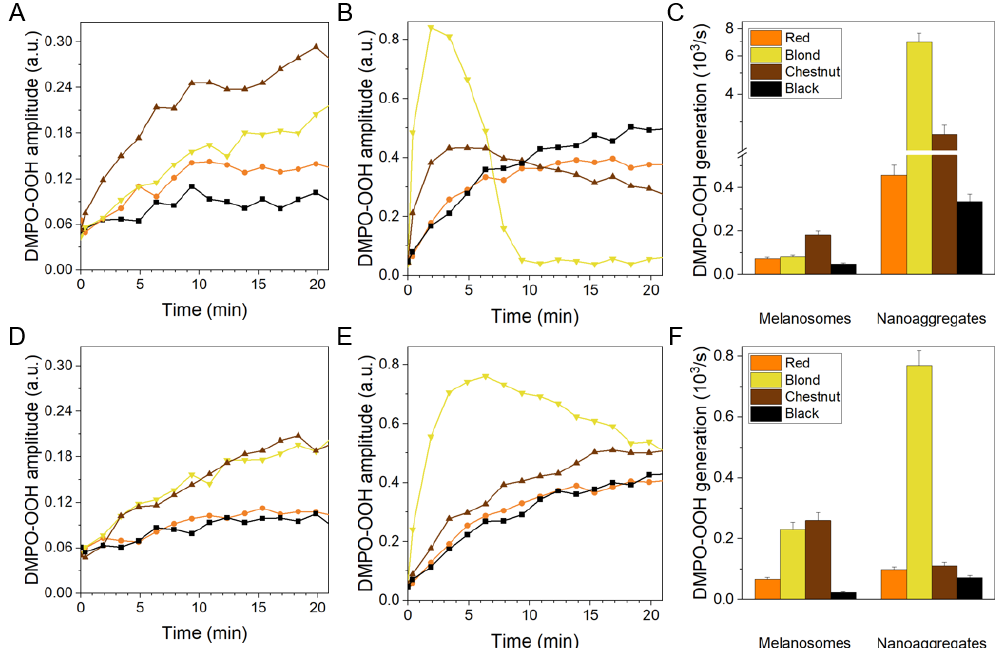
Figure 6. Kinetics of superoxide anion generation, detected as the formation of DMPO-OOH spin adduct during irradiation of the samples with 365 nm ( A – C ) and 445 nm ( D – F ). ( A , D ) show results for melanosomes whereas ( B , E ) show results for melanin nanoaggregates. ( C , F ) show histograms of initial velocities of DMPO-OOH generation by both melanosomes and nanoaggregates of different hair melanins. Color lines indicate the following samples: orange (red hair), yellow (blond hair), brown (chestnut hair), and black (black hair).